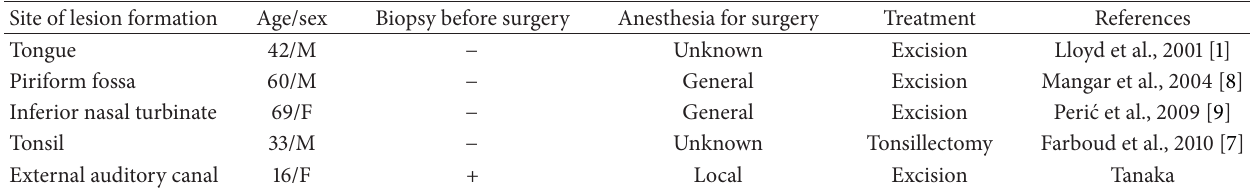
Table 1: Literature review of fibroepithelial polyp occurring independently in the head and neck area (excluding skin) since 2000.